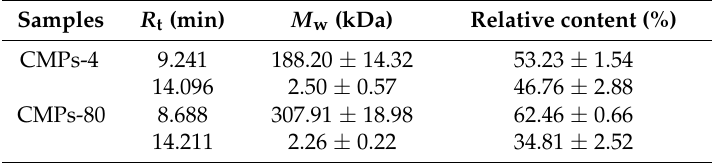
Table 2. Molecular weight distribution of CMPs-4 and CMPs-80 (mean ± s, n = 3). Samples